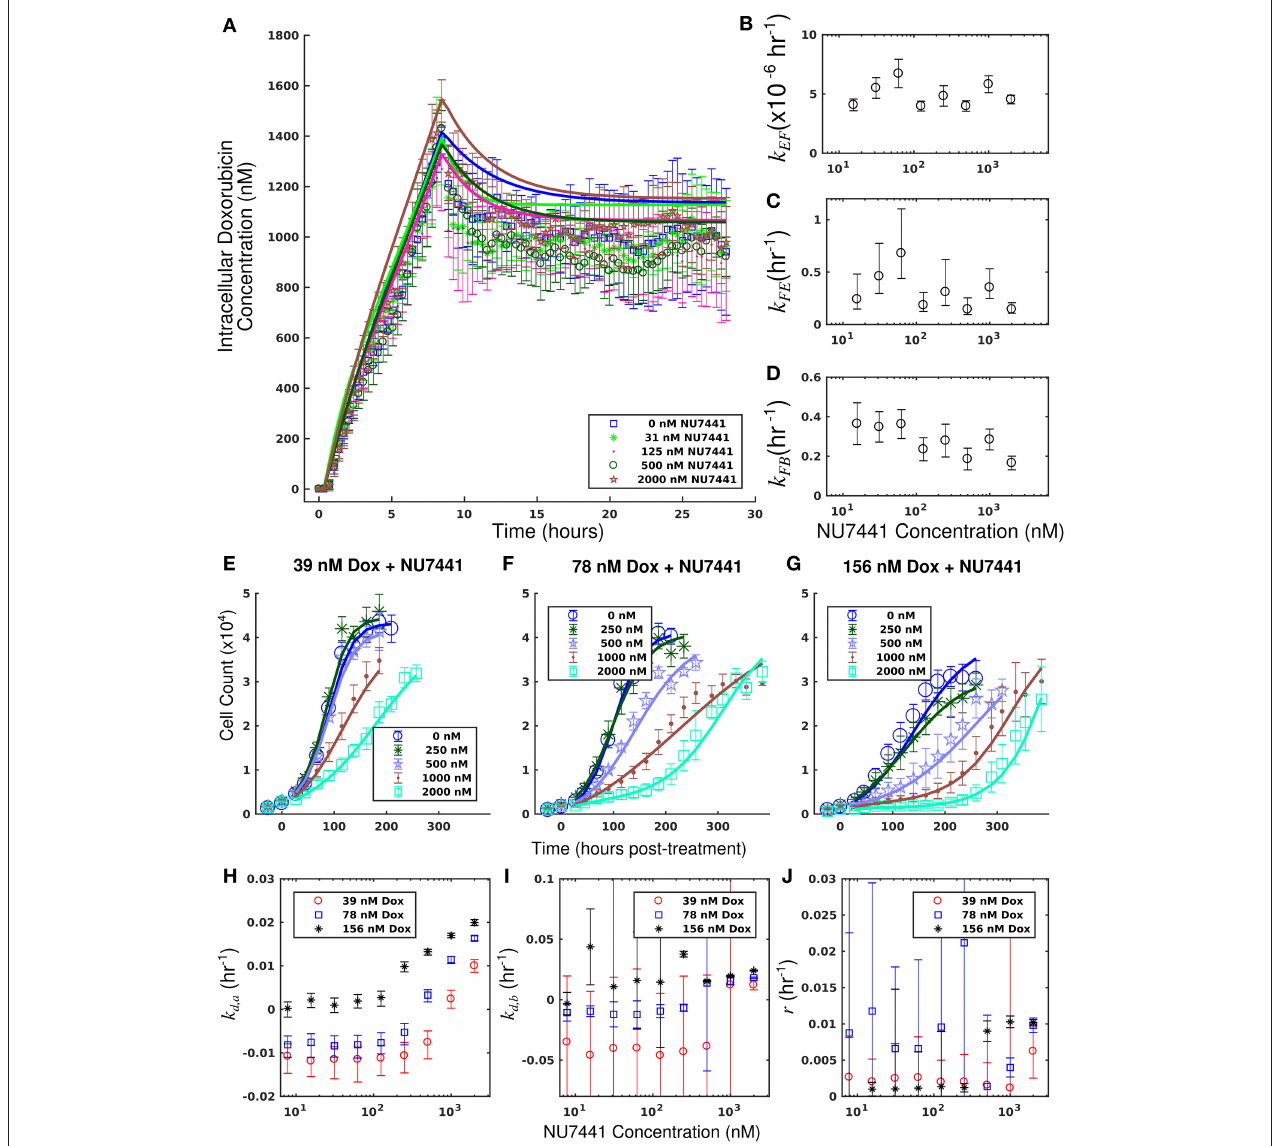
FIGURE 5 | Doxorubicin and NU7441 combination studies in the SUM-149PT cell line. Timecourses of the mean intracellular concentration of doxorubicin with corresponding standard deviations are shown for each treatment condition in a. No significant difference in doxorubicin accumulation was observed as a function of NU7441 concentration. Equations (1–3) were fit to the data, and the best-fit models are overlaid on the data (smooth lines) in (A) . Model parameter fits corresponding to the best-fit models are shown in (B–D) . For each model parameter, similar vales were observed across all NU7441 concentrations, consistent with the similar intracellular doxorubicin timecourses in (A) . Counts of SUM-149PT cells following combination treatment with NU7441 and doxorubicin are show in panels (E–G) . In each plot, a fixed concentration of doxorubicin is applied with variable NU7441 concentrations. These counts are fit with Equations (4–6) as described in section Model Fits, and the best-fit models are overlaid on the cell counts [smooth lines in panels (E–G) ]. Error bars represent the 95% CI from six experimental replicates for each treatment condition. Model parameters with corresponding 95% CI are shown in panels (H–J) as a function of NU7441 concentration. For each doxorubicin concentration, the death rate ( k d , a ) increased with NU7441 concentration (H) . The parameters shown in panels (I,J) are unable to be resolved with the current data as discussed in section Model Fits.